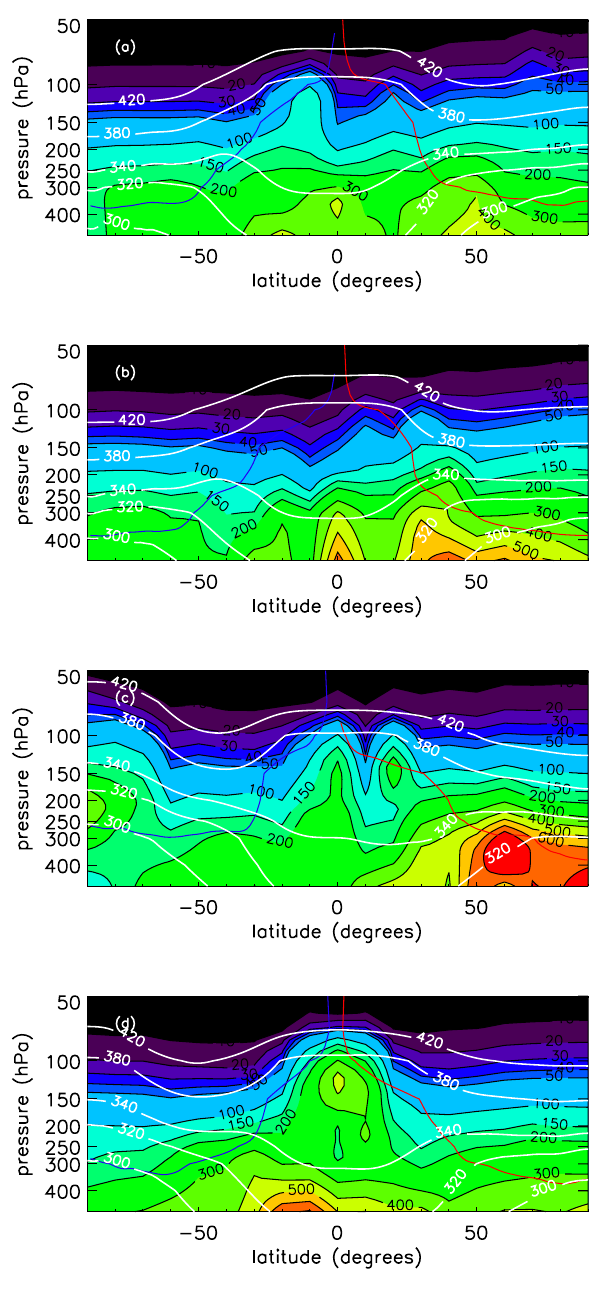
Fig. 10. Seasonal latitudinal PAN distribution (units ofpptv), aver- aged zonally for (a) January 2003, (b) March 2003, (c) August 2003 and (d) October 2003. The white lines indicate theta levels (K) and the red and blue lines represent the +/ − 2PVU levels